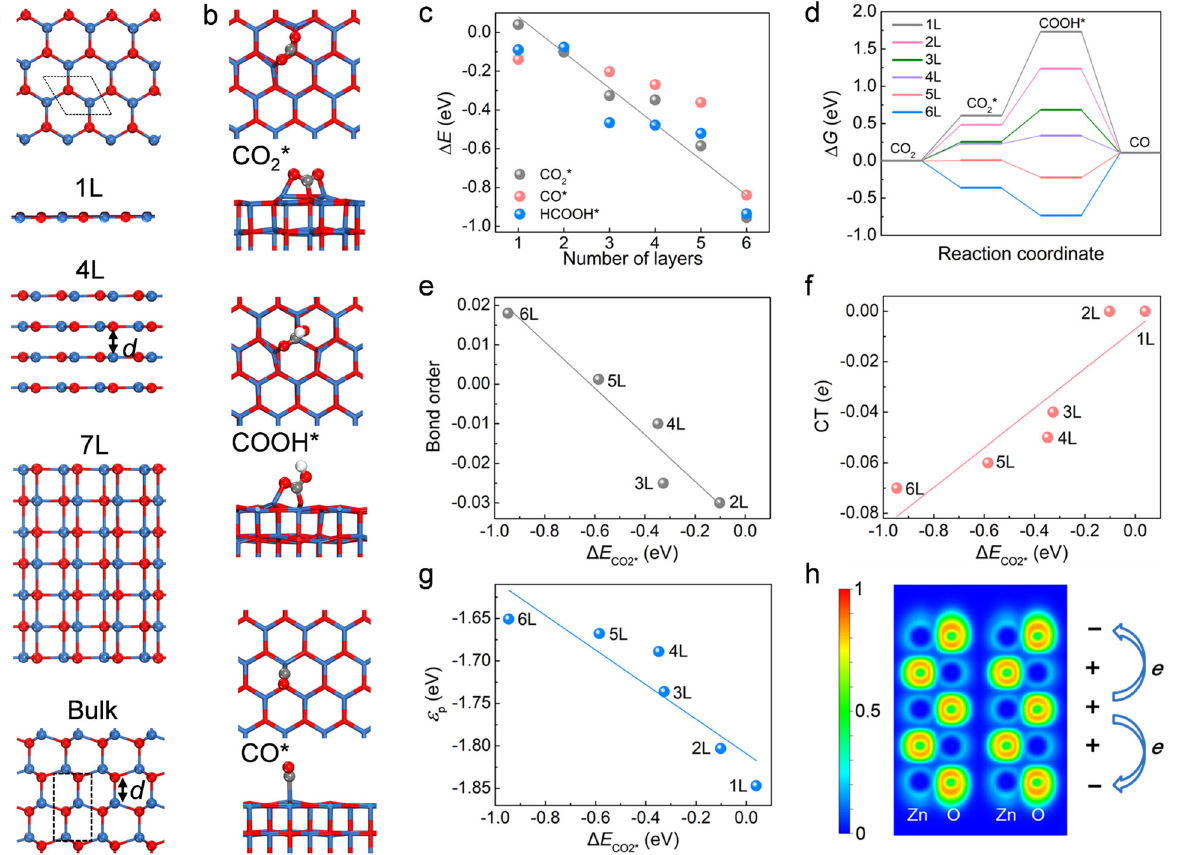
Fig. 6 2D ZnO sheets for CO 2 reduction. a Atomic structures of 2D ZnO (top panel: top view; bottom panels: side views of 1L, 4L, 7L, and bulk ZnO). b Atomic structures of CO 2 , COOH*, and CO* intermediates adsorbed on 2D ZnO. c Adsorption energies of CO 2 , CO, and HCOOH on 2D ZnO as a function of the number of layers. d Free energy diagram of CO 2 reduction to CO on 2D ZnO. e Mulliken bond order of Zn – O bonds from adjacent layers. f Mulliken charge per formula unit, and g 2 p band center of the surface O atoms of 2D ZnO as a function of CO 2 adsorption energy. h Electron localization function of 5 L ZnO with red (blue) color showing maxima (minima), and schematic plot of electron distribution on the surface and in the interior of 2D ZnO (images are adapted from ref. 192 , Copyright © The Royal Society of Chemistry